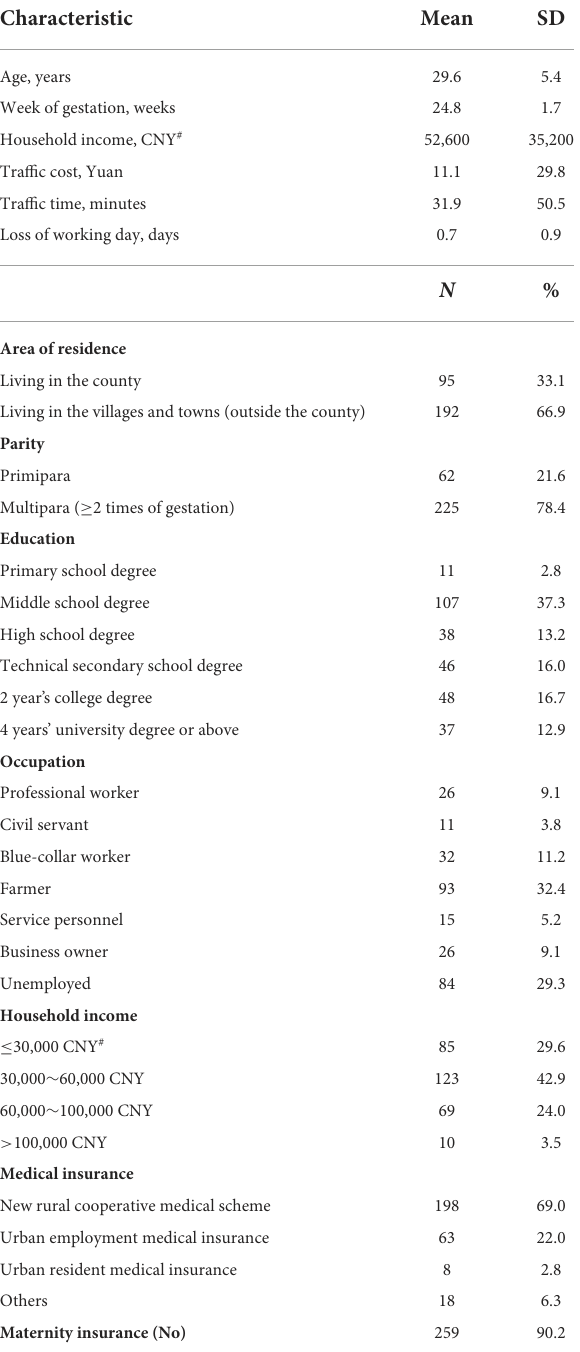
TABLE 2 Socio-demographic characteristics of respondents ( N =